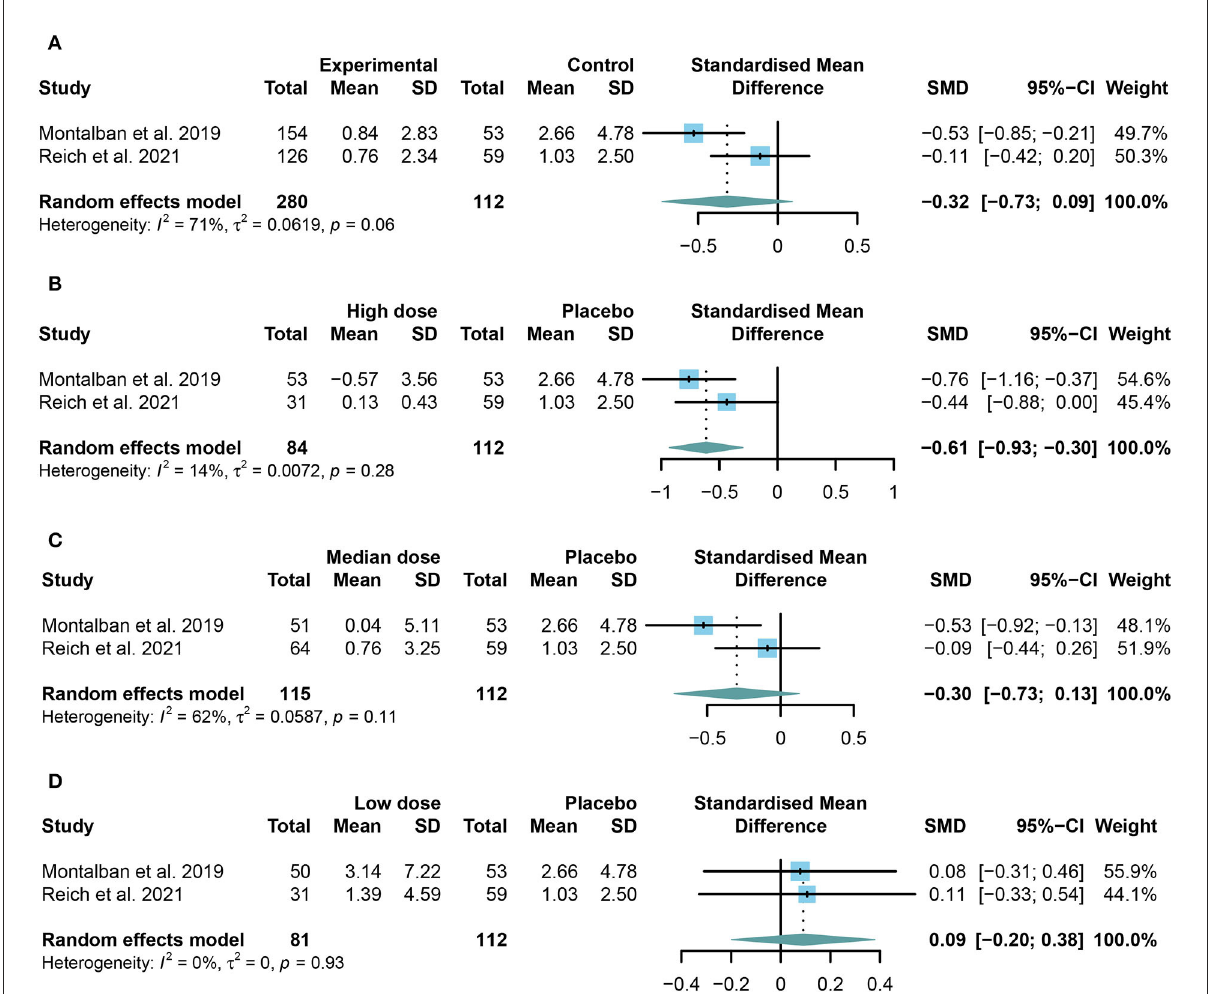
FIGURE2 The pooled standard mean differences (SMDs) of the change in the cumulative number of gadolinium-enhancing lesions on T1-weighted MRI in different doses of TKIs compared with the placebo group; the diamond indicates the estimated summary SMDs with a 95% confidence interval (CI): (A) summary of different doses of TKIs compared with the placebo group; (B) high dose of TKIs compared with the placebo group; (C) median dose of TKIs compared with the placebo group; (D) low dose of TKIs compared with the placebo